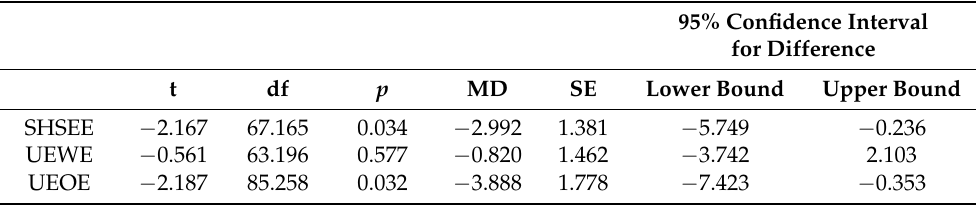
Table 4. Entrance examination results between NSMMP ( n = 70) and SMMP ( n = 30)